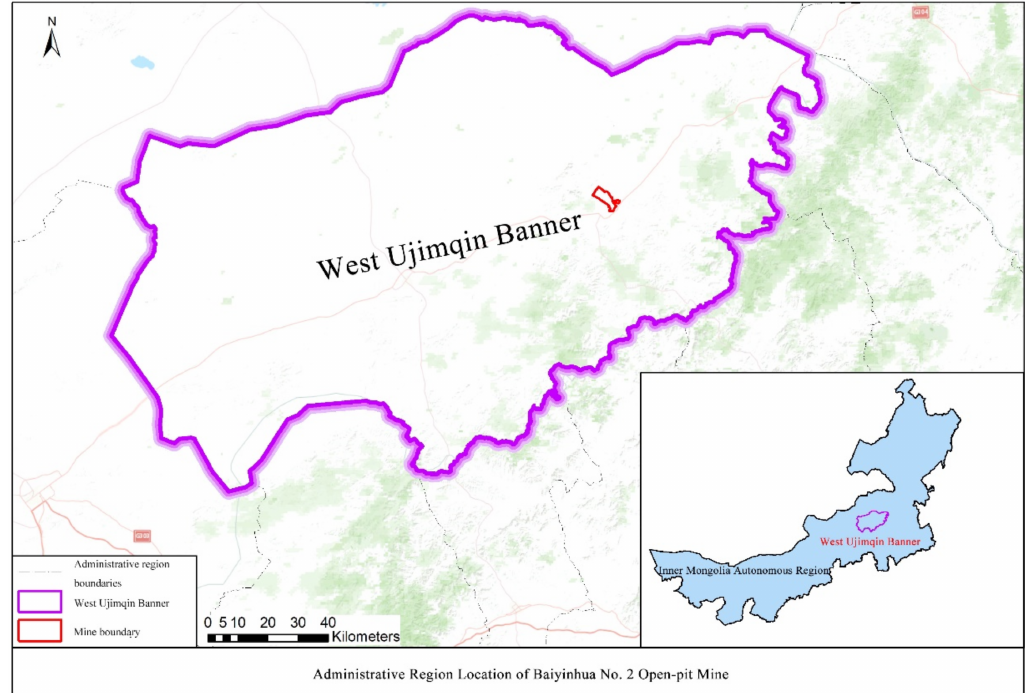
Figure 1. Administrative region location of Baiyinhua No. 2 Open-pit